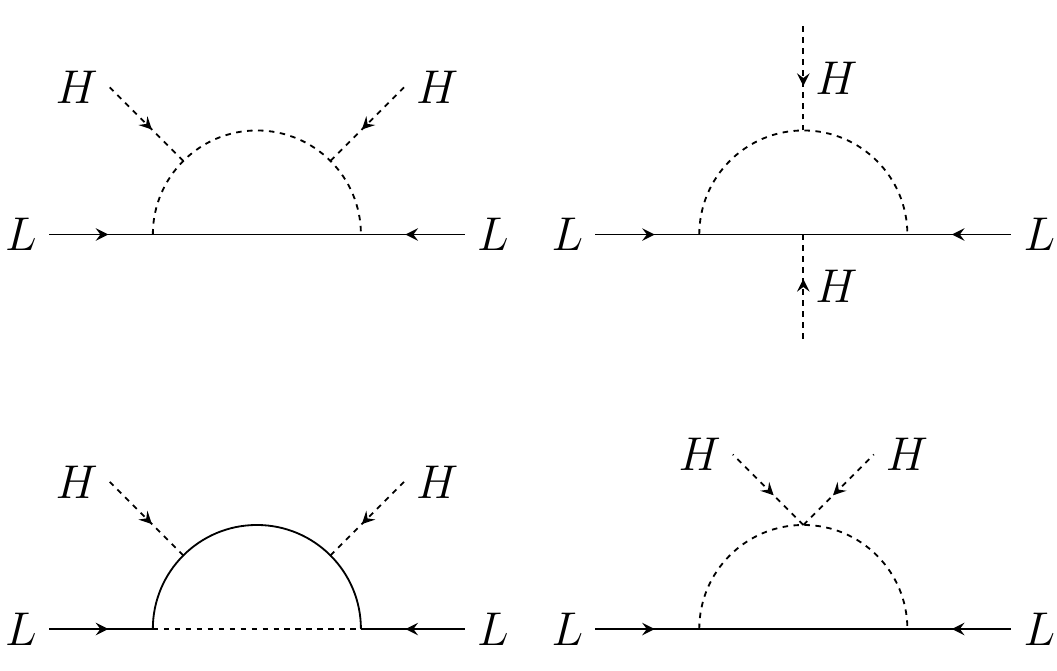
Figure 1 . The four different 1-loop diagrams that can lead to genuine neutrino mass models [15]. Top line: T-I-1 (left) and T-I-2 (right), bottom T-I-3 (left) and T-3